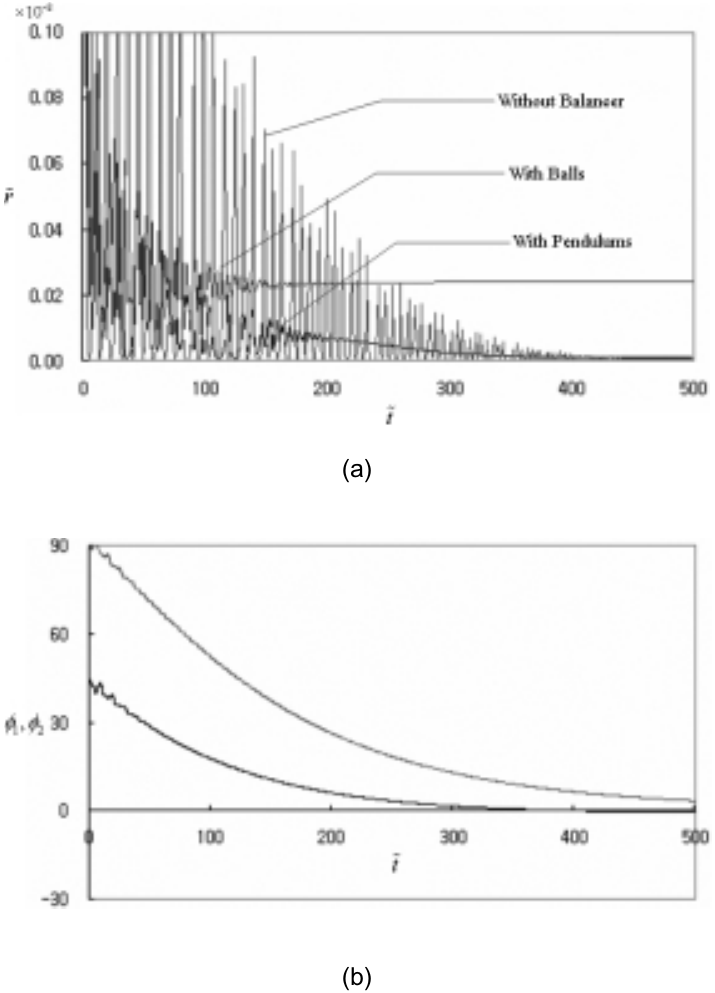
Fig. 11. Time response of system with Pendulum or Ball Automatic Dynamic Balancer for ˜ ω = 0 . 2 and ˜ m = 0 . 116 . (a) Time response of the radial displacement. (b) Time response of the pendulum